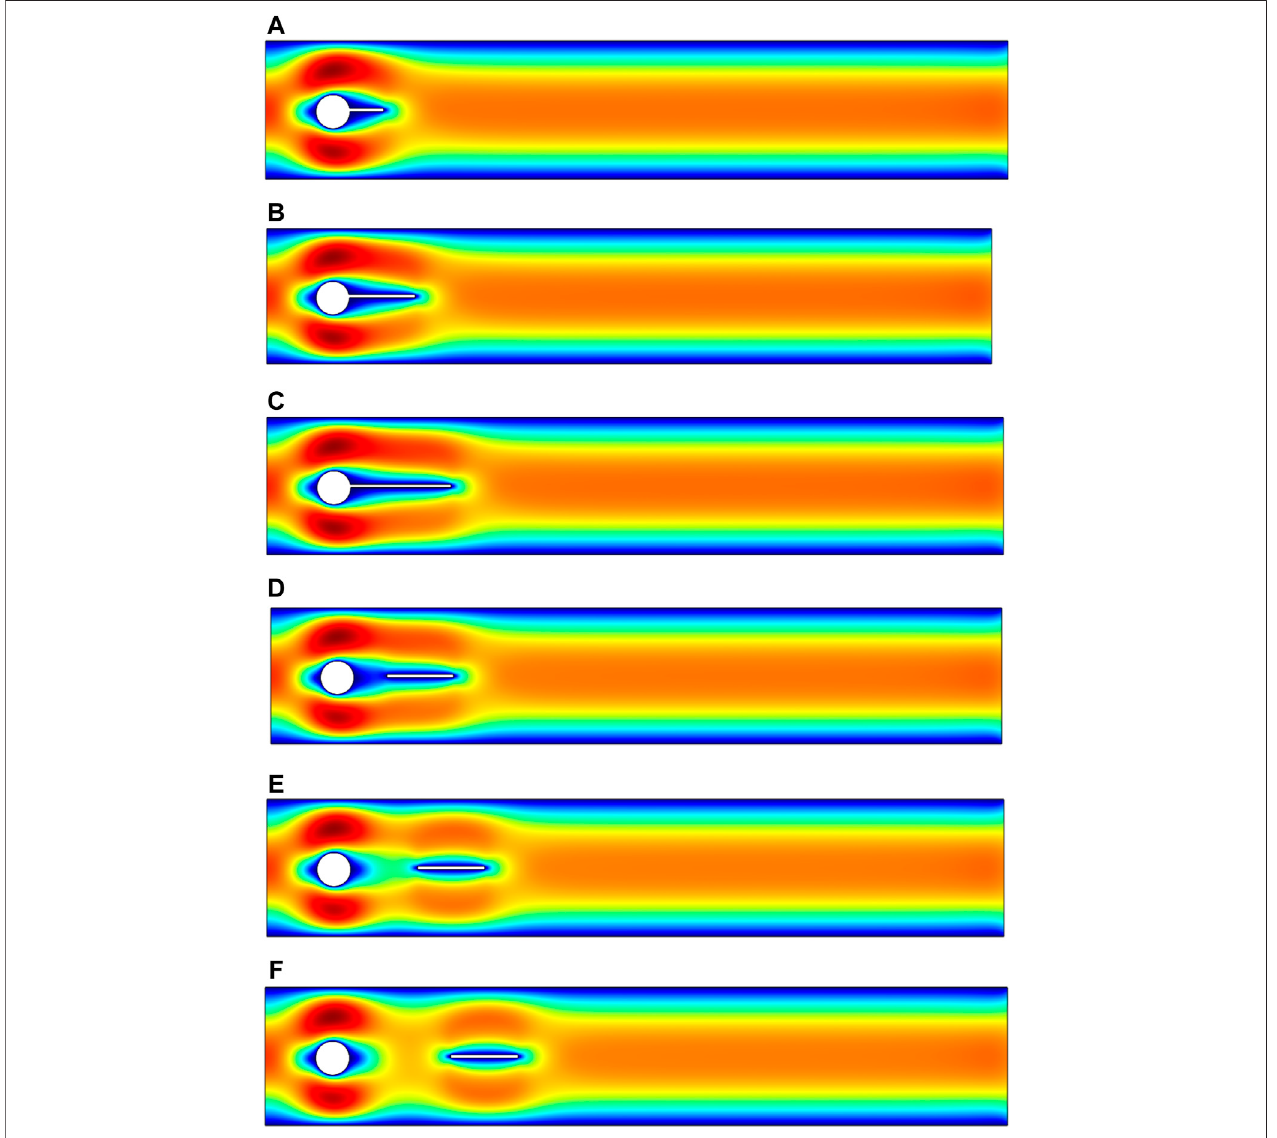
FIGURE 12 | In fl uence of an attached splitter plate of length (A) L 1 = 0.1, (B) L 2 = 0.2, (C) L 3 = 0.3 and gap separation (D) G 1 = 0.1, (E) G 2 = 0.2, (F) G 3 = 0.3 on velocity, at (cid:2) t (cid:1) 10 .